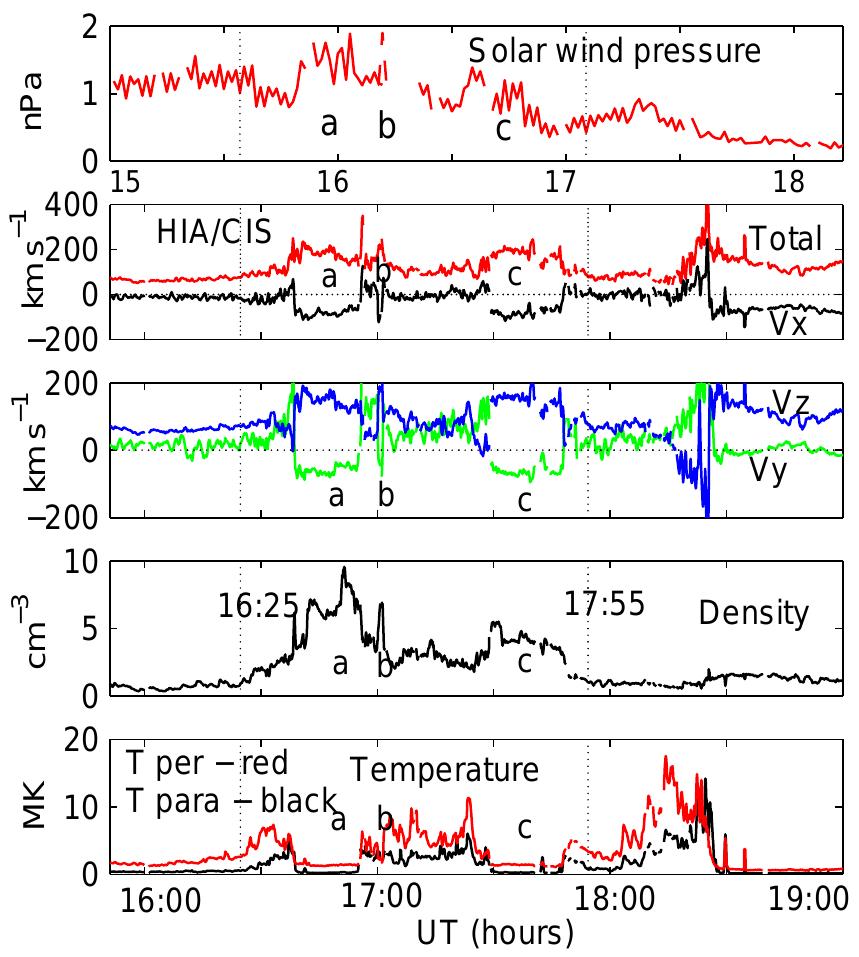
Fig. 4. The CIS data during 15:50–19:00 UT on 18 April 2002 and solar wind dynamic pressure (top panel), shifted by 50min. The CIS data are the total ion velocity in red and its X-component V x in black (panel 2), V y and V z components (panel 3), ion density (panel 4), and parallel (black) and perpendicular (red) ion temperatures (panel 5) measured by HIA/CIS on Cluster SC3. The time interval (16:25–17:55 UT) between the vertical lines corresponds to the period of interest; a, b and c are anti-sunward ion flow events during 16:38:42–16:56:10 UT, 17:00:10–17:01:40 UT, and 17:29:15–17:48:28